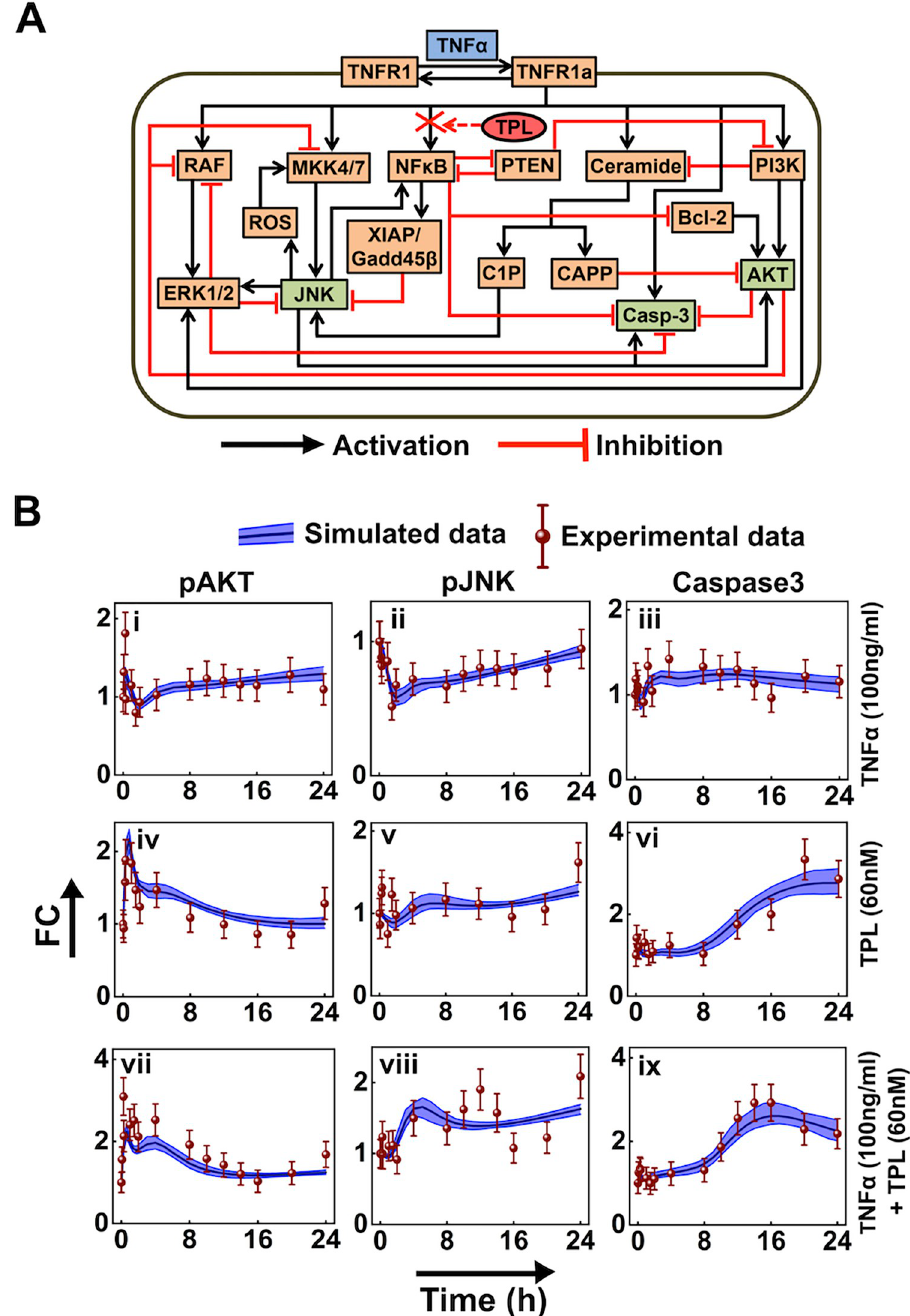
Fig 2. Interaction network and model training with quantitative time resolved data of U937 cells. (A) Schematic of TNF α signaling network. Black arrows and red hammers, respectively represent activation and inhibition of entities. While green boxes indicate experimentally measured marker proteins, red cross captures NF κ B inhibition by TPL (red oval). Multiple pathways from NF κ B inhibiting Caspase3 are lumped as a single inhibitory interaction. (Details of the entities and the interactions are in S2 Text.) (B) A comparison of the experimentally measured (red-wine circles) and model estimated signaling marker trajectory of pAKT (i, iv, vii), pJNK (ii, v, viii), and Caspase3 (iii, vi, ix) under different stimulation conditions. In each of these, black lines capture the mean of best 3% model-fitted trajectories. The blue cloud around the mean encompasses all 3% best-fitted trajectories. Note that the experimental measurements are those in Fig 1C. To constrain the model better, two additional data points (10 and 14 hours) were included during parameter estimation. The levels at these two time points were estimated using spline fitting the experimental data. Error bar around each experimental data point were calculated using standard error